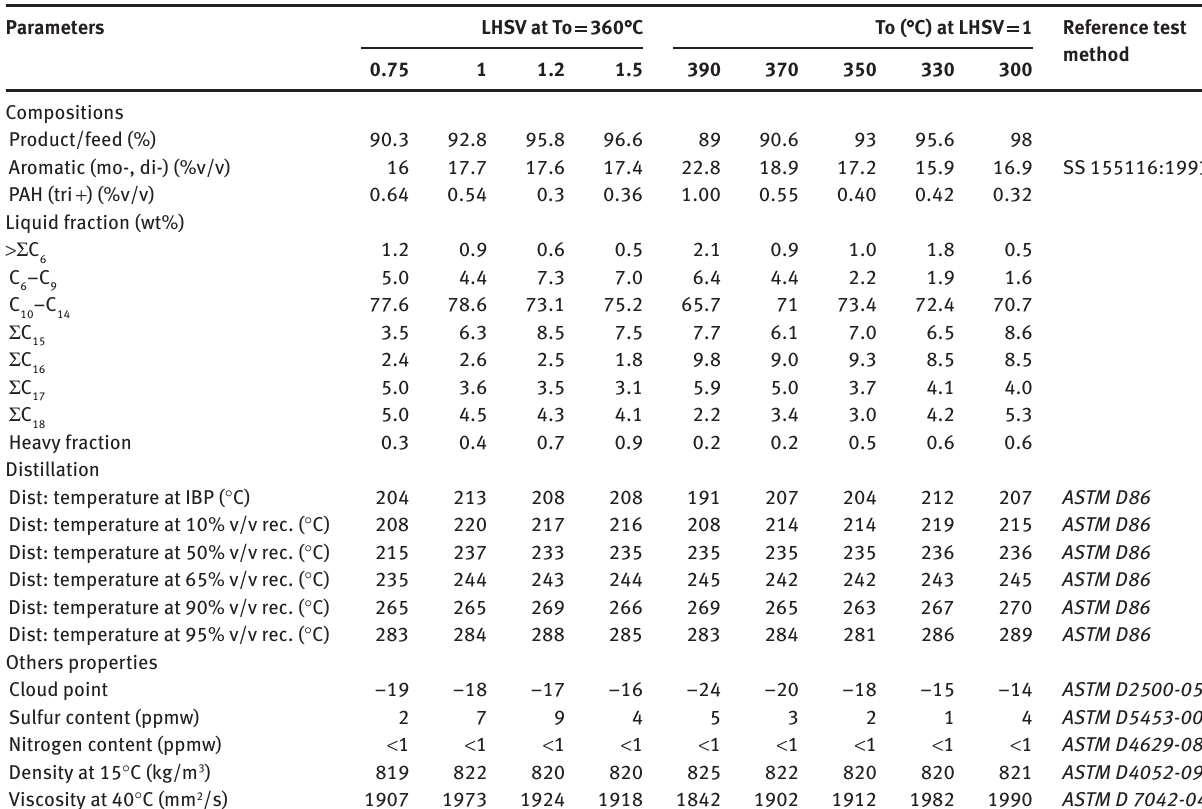
Table 3: Physicochemical properties of the product from 10% fatty acid methyl ester (FAME) + light gas oil (LGO) by Ni-Mo catalyst for varied temperatures and a feed space velocity at 5 MPa